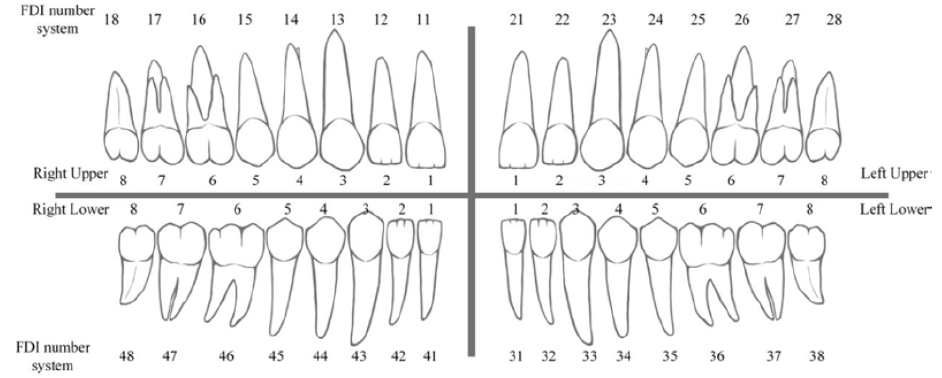
Figure 3. FDI classification.